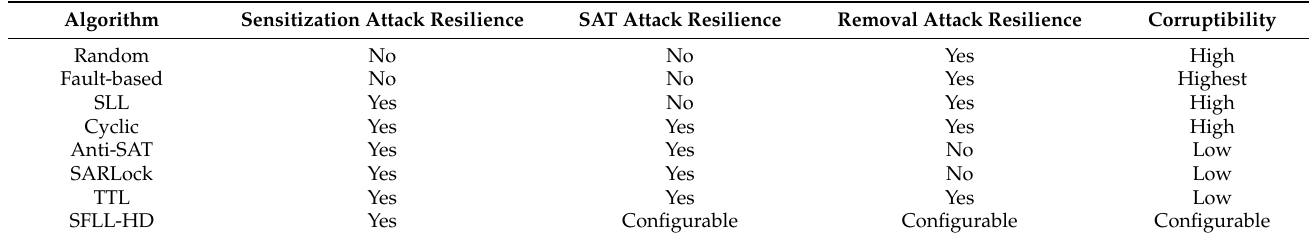
Table 1. Comparison of logic locking